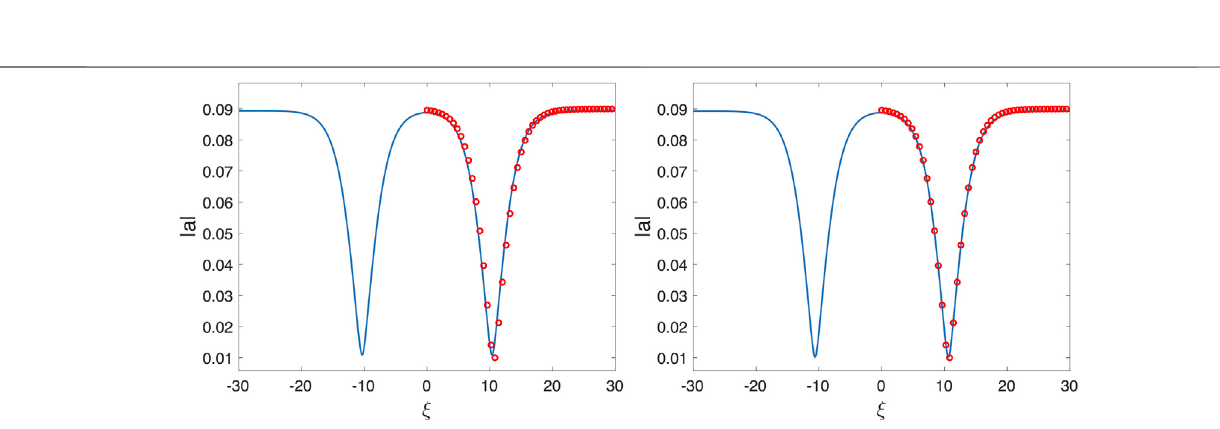
Frontiers in Physics |